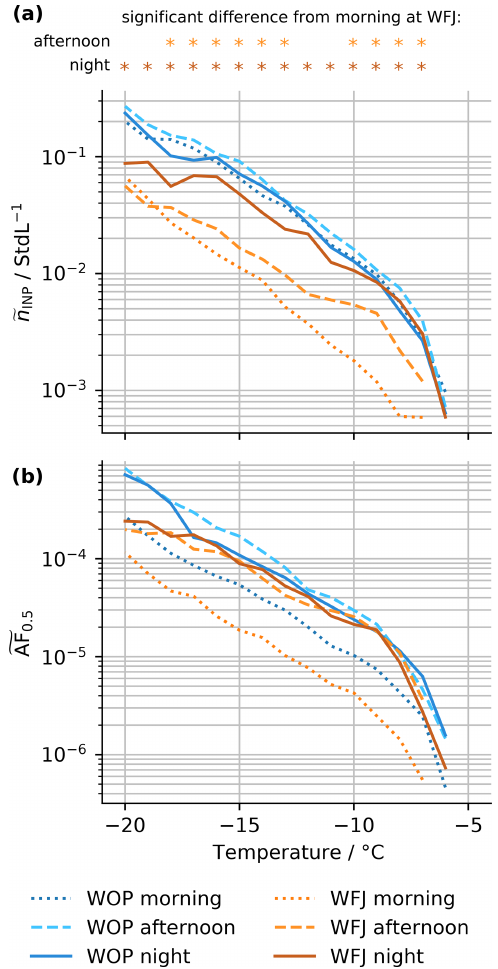
Figure 5. Median (cumulative) INP concentrations (cid:101) n INP (a) and median activated fractions (cid:102) AF 0 . 5 (b) for the mountaintop (WFJ; or- ange) and high valley (WOP; blue) sites for the three time periods of the day. The morning period (03:00–11:59UTC; in dots), afternoon period (12:00–17:59; dashed), and night period (18:00–02:59UTC; solid) are shown (see dotted lines in Fig. 4b and c). Above panel (a) , asterisks indicate if the median INP concentration at WFJ in the af- ternoon and night, respectively, is significantly (significance level p < 0 . 05) different from in the morning based on a Mann–Whitney U test per